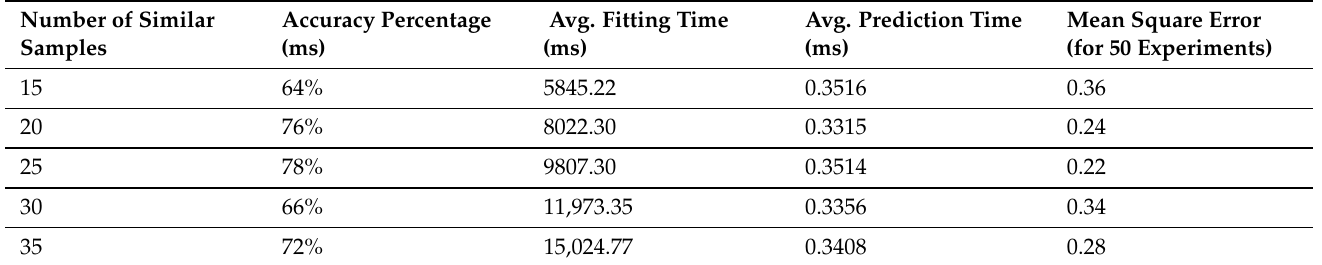
Table 7. TWNFI evaluation with a different number of local model samples, with Dthr = 0.2, on a dataset of 250